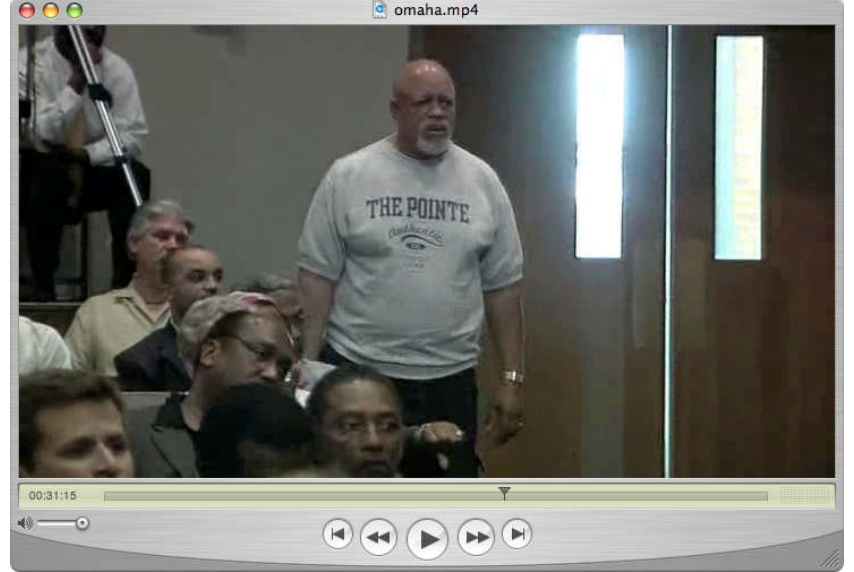
Figure 13: Explicit indexing of trust: “Why would I ever trust the Chamber of